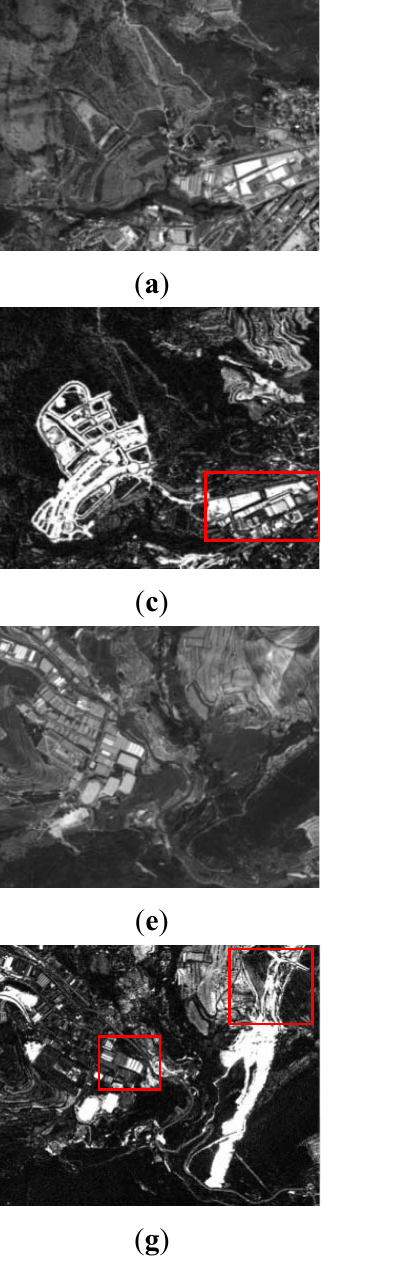
Figure 4. Level 2 processing, SPOT5 PAN ( a ) area A1: 2005 image; ( b ) area A1: 2008 image; ( c ) area A1: CD Difference index; ( d ) area A1: CD Ratio index; ( e ) area A2: 2005